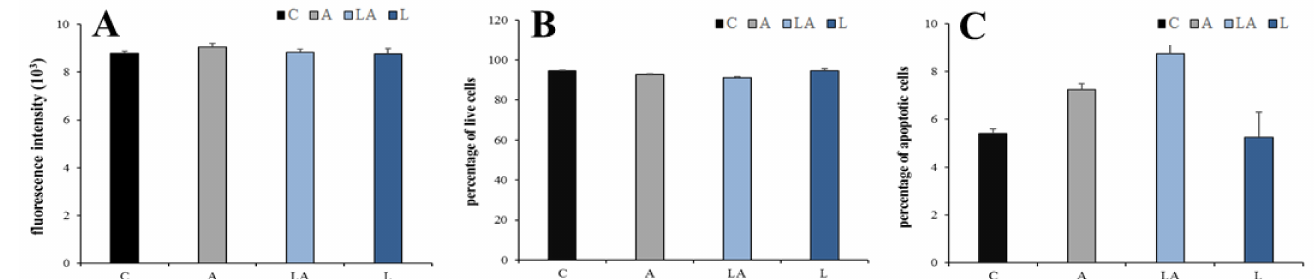
Figure A2. The effect of lactic acidosis on cancer cell viability. Viability ( A ) of PaTu-8902 cells cultured in experimental media for 72 h. Percentage of living ( B ) and apoptotic ( C ) cells in the cell population cultured in experimental media for 72 h. Viability was measured by resazurin assay. Apoptosis was determined using flow cytometry. C, control; A, acidosis; LA, lactic acidosis; L, high lactate.